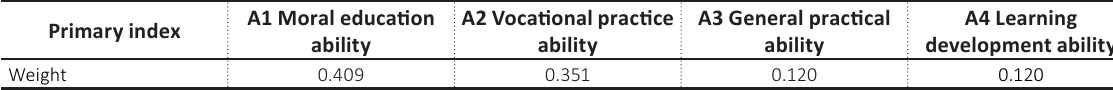
Table 5. Weight of primary indexes